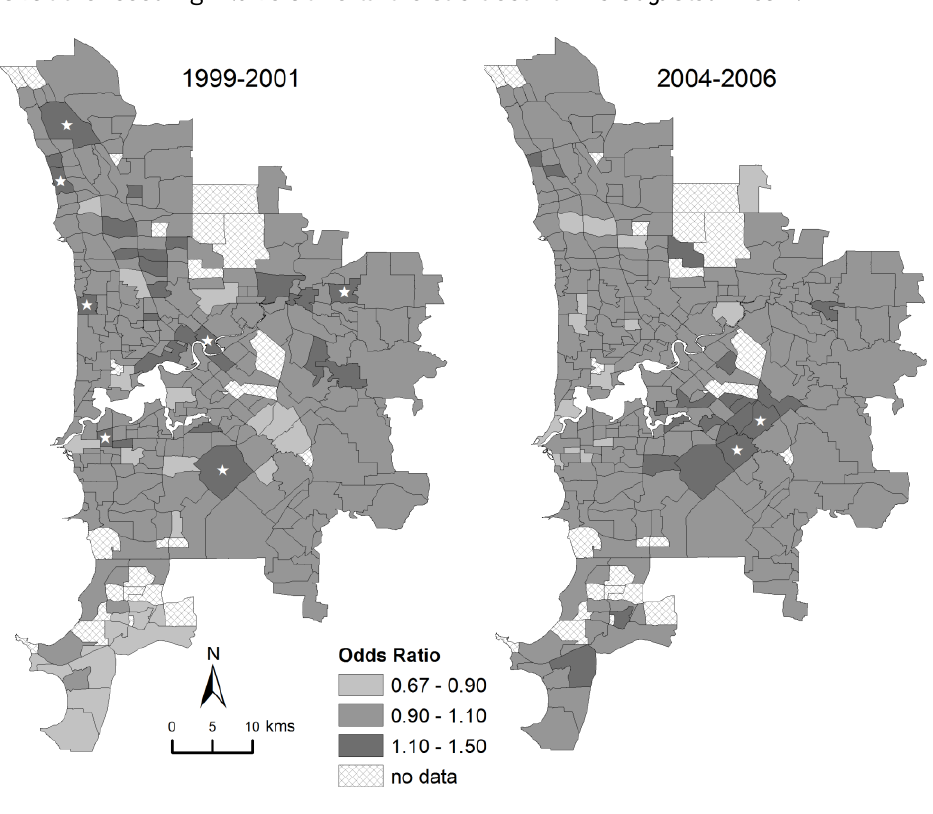
Figure 4. Mapped residual variation in the incidence of poor fetal growth in Perth after accounting for socioeconomic status. This shows the odds ratio of poor fetal growth, calculated from the sum of spatially-correlated and uncorrelated random effects from the full (mixed) model. Stars denote suburbs with a posterior probability greater than 0.90 of the odds ratio exceeding 1.0 relative to the socioeconomic-adjusted